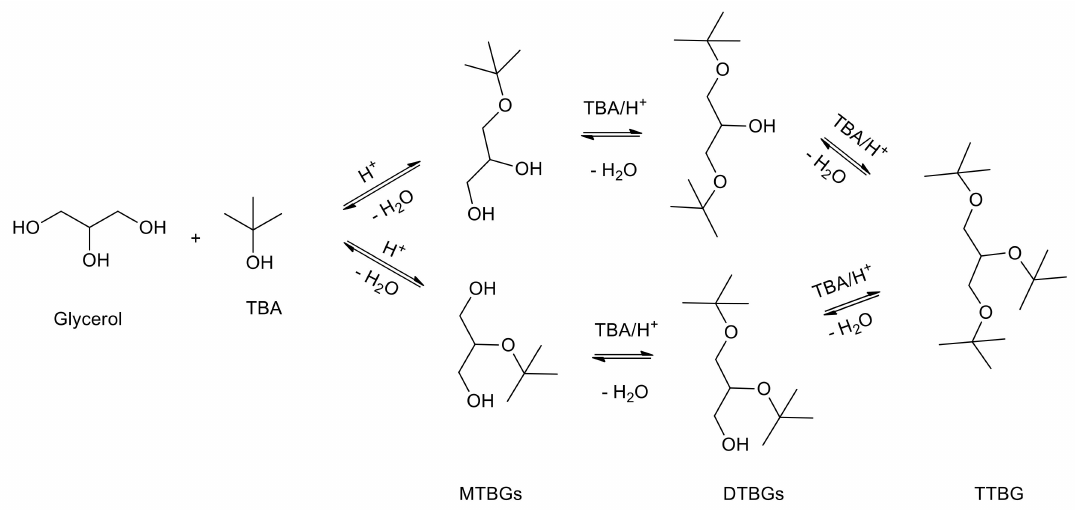
Figure 1. Reaction pathways for the etherification of glycerol with tert-butyl